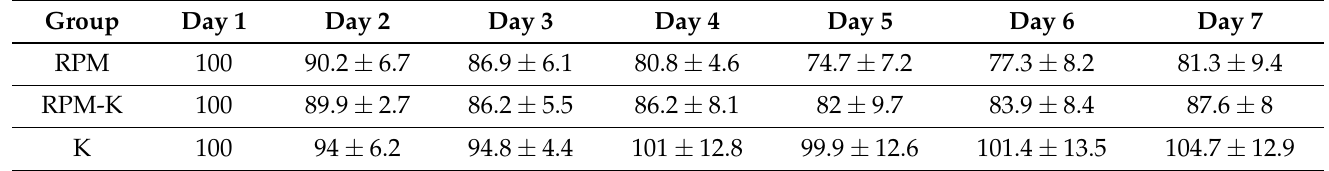
Table 3. Mass of the animals (in percentages) through the experimental period (mean ± SD).